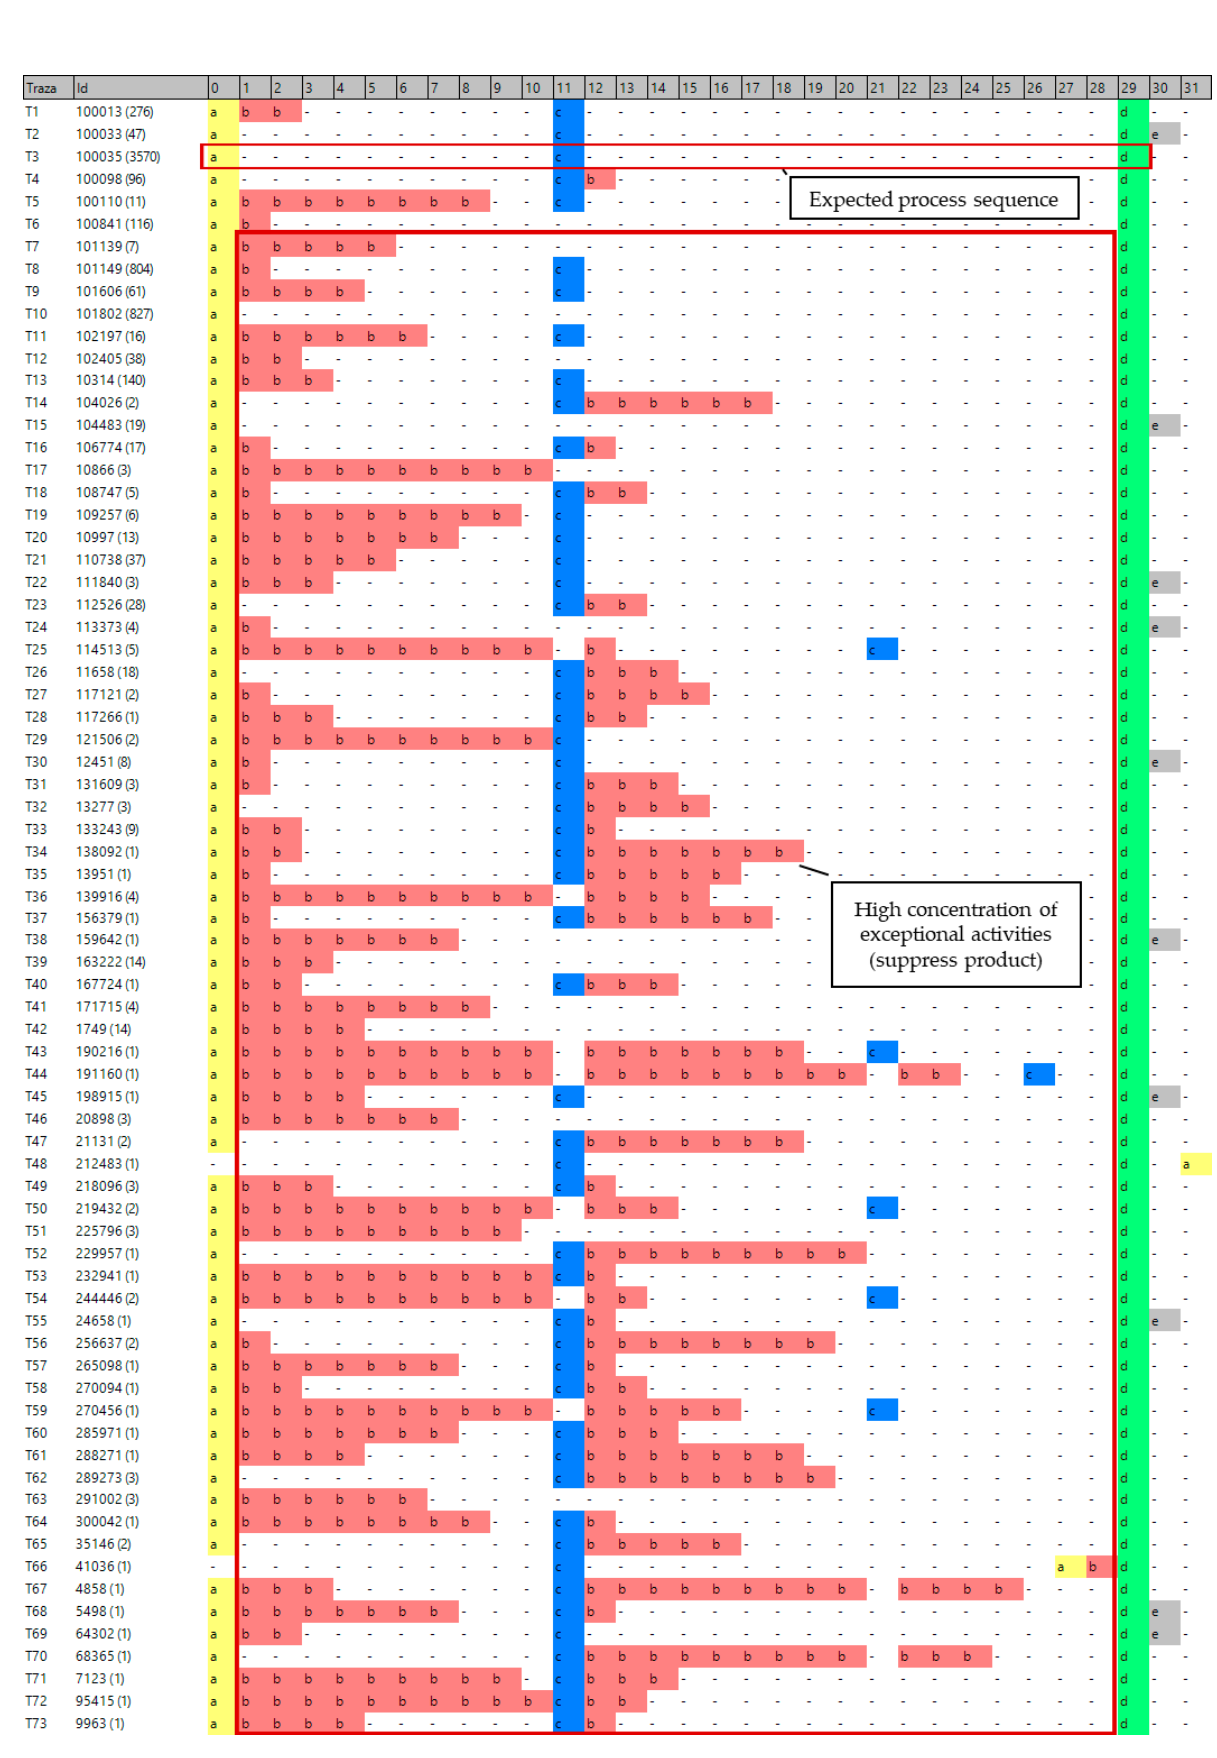
Figure 11. View of the different sequences of the process activities.